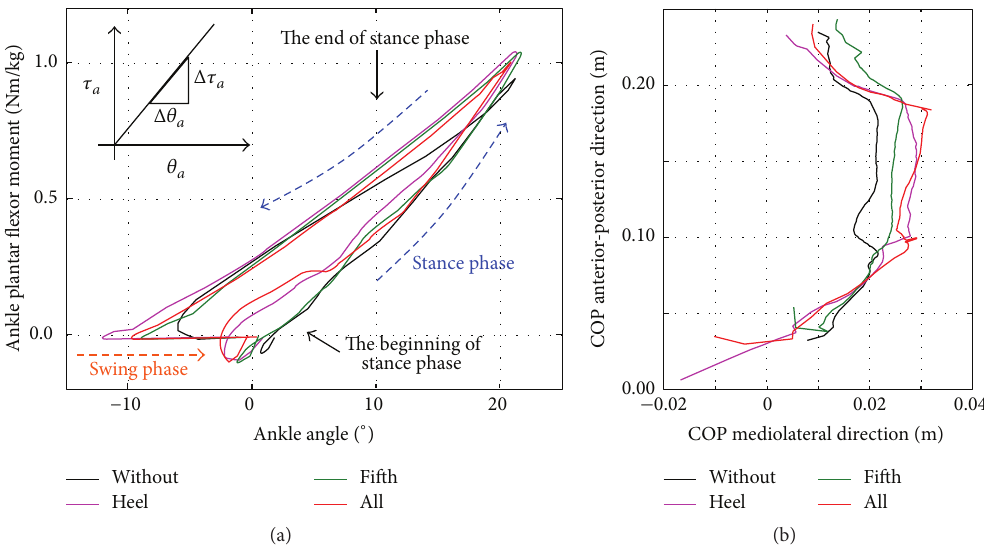
Figure 6: (a) Effects on dynamic joint stiffness of the ankle joint on the affected side: dynamic joint stiffness decreases in the beginning of the stance phase in (ii) “heel” and (iv) “all” conditions, whereas stiffness increases in the late stance phase in (ii) “heel,” (iii) “fifth,” and (iv) “all” conditions, which are similar to that of walking in normal subjects [9]. (b) Effects on COP trajectory on the affected side. The posterior position of COP in the conditions (ii) and (iv) moves backward at the beginning of the stance phase, whereas the anterior position in the conditions (iii) and (iv) moves forward at the end of the stance